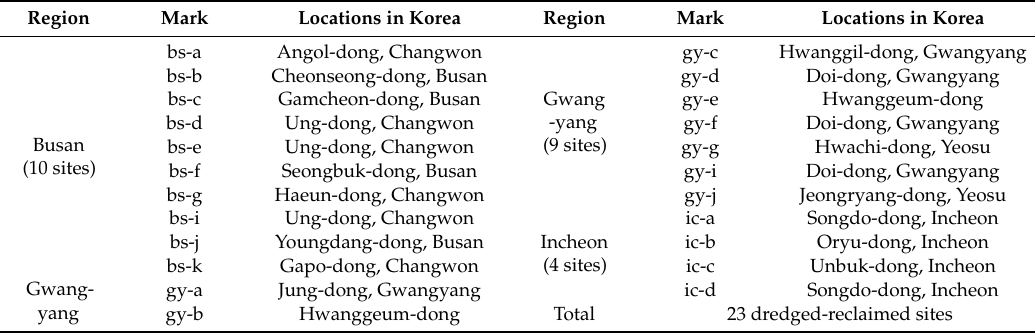
Figure 1. The samples were separated into three regions: the Busan, Gwangyang, and Incheon regions. Table 1. Sampling